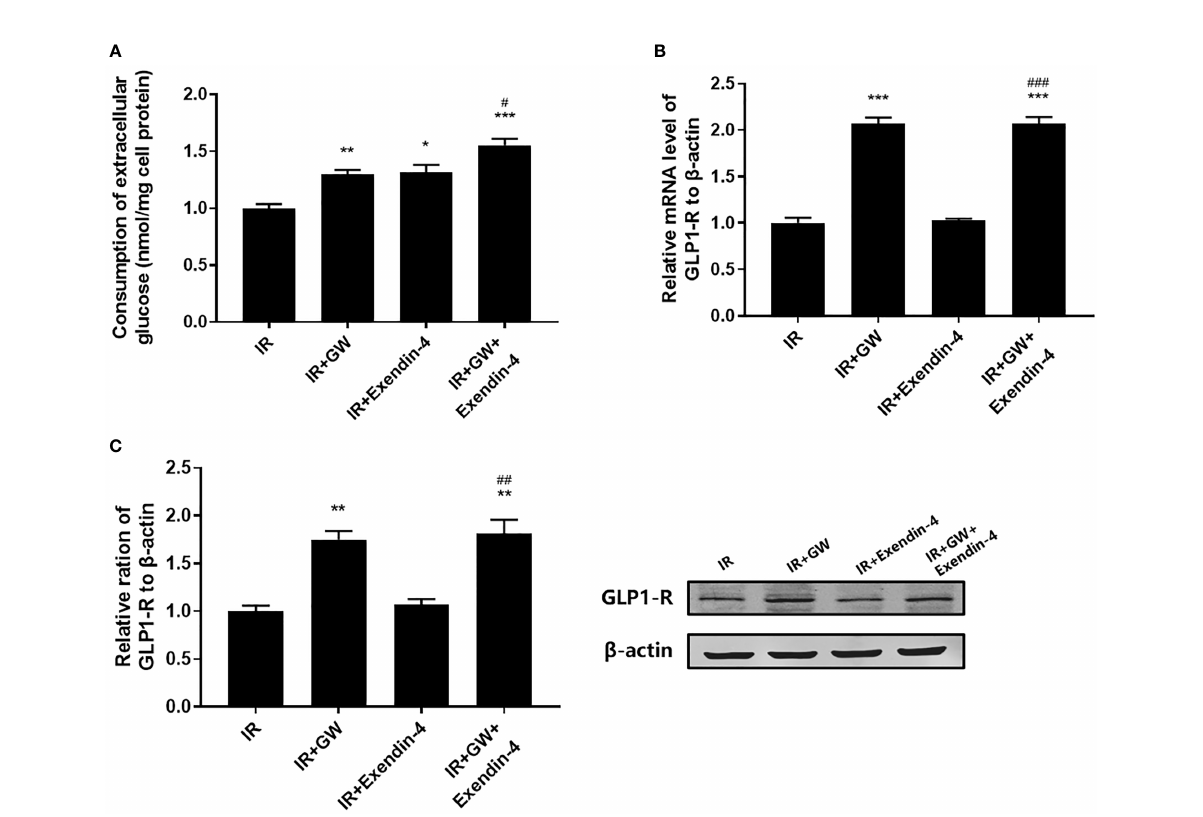
FIGURE 3 Effect of PPAR d agonists (GW501516) on the exenatide therapeutic ef fi cacy by regulating the expression of GLP-1R. (A) Enzymatic methods were used to assay for glucose. (B) The mRNA level of GLP-1R was measured by RT-PCR. (C) The relative protein expression level of GLP-1R was measured by Western blot. Data are expressed as the mean ± SE, n = 3. * P < 0.05, ** P < 0.01 and *** P < 0.001 compared with IR. # P < 0.05, ## P < 0.01 and ### P < 0.001 compared with